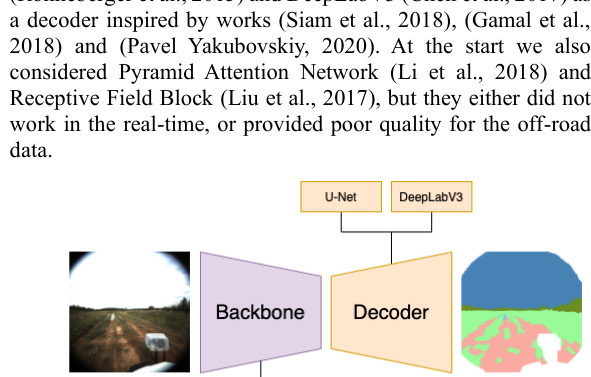
Table 1. Reprojection errors in orientation calculations for different numbers of attempts.